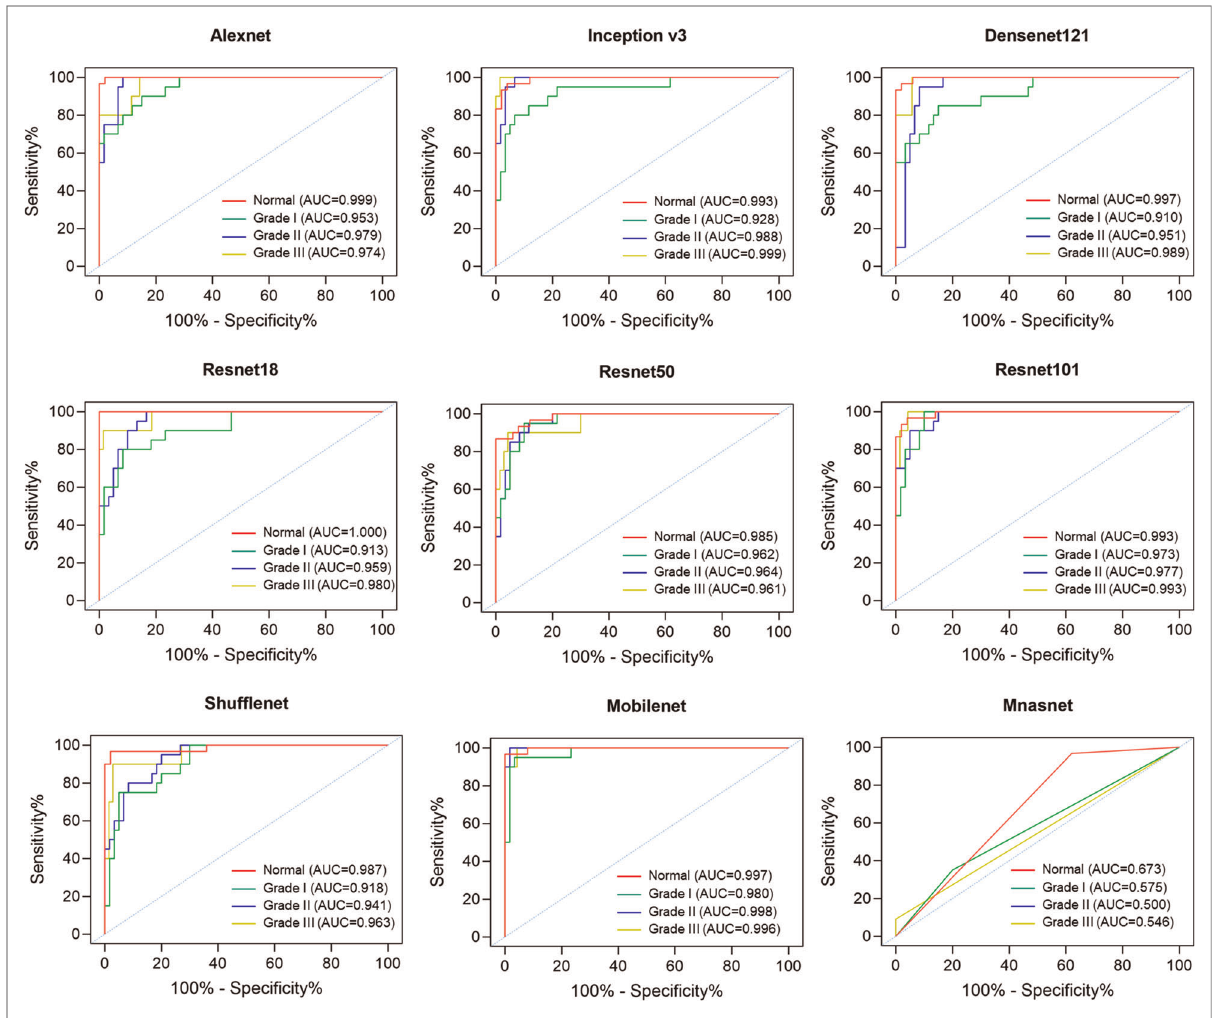
FIGURE 4 The ROC curves of the convolutional neural networks for assessing the severity of